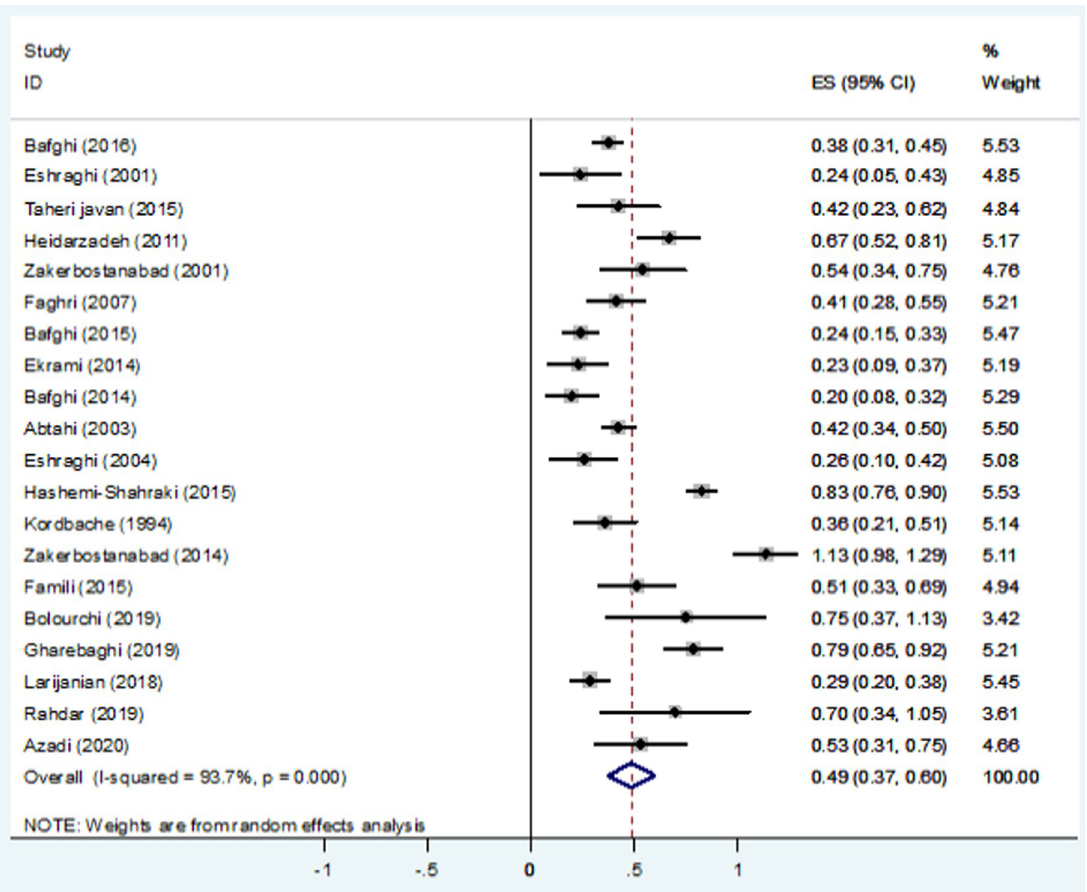
Fig 2. Forest plot of meta-analysis of Nocardia prevalence in Iran based on random-effect models. and the growth phase of the nocardial cells. Virulent Nocardia can be explained by the com- plexity of cell wall glycolipids that prevents the fusion of phagosome-lysosome, declines the